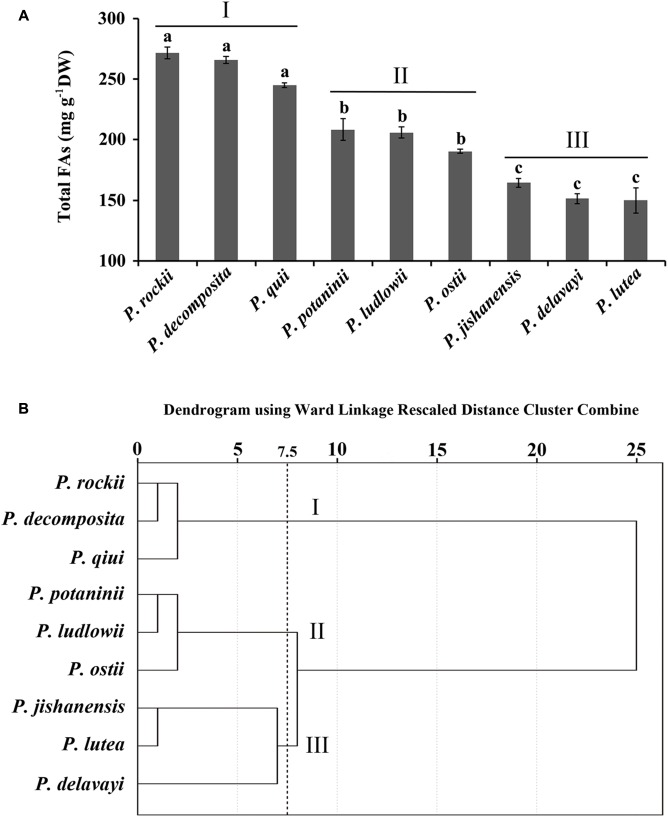
Association of nine tree peony species based on fatty acid content and composition. (A) Nine species were divided into groups I, II, and III based on their FA abundance. Data are mean ± SD with n = 3. Bars with no letters in common are significantly different (p < 0.01). (B) Dendrogram showing the association of nine species in clusters based on their FA content and composition.